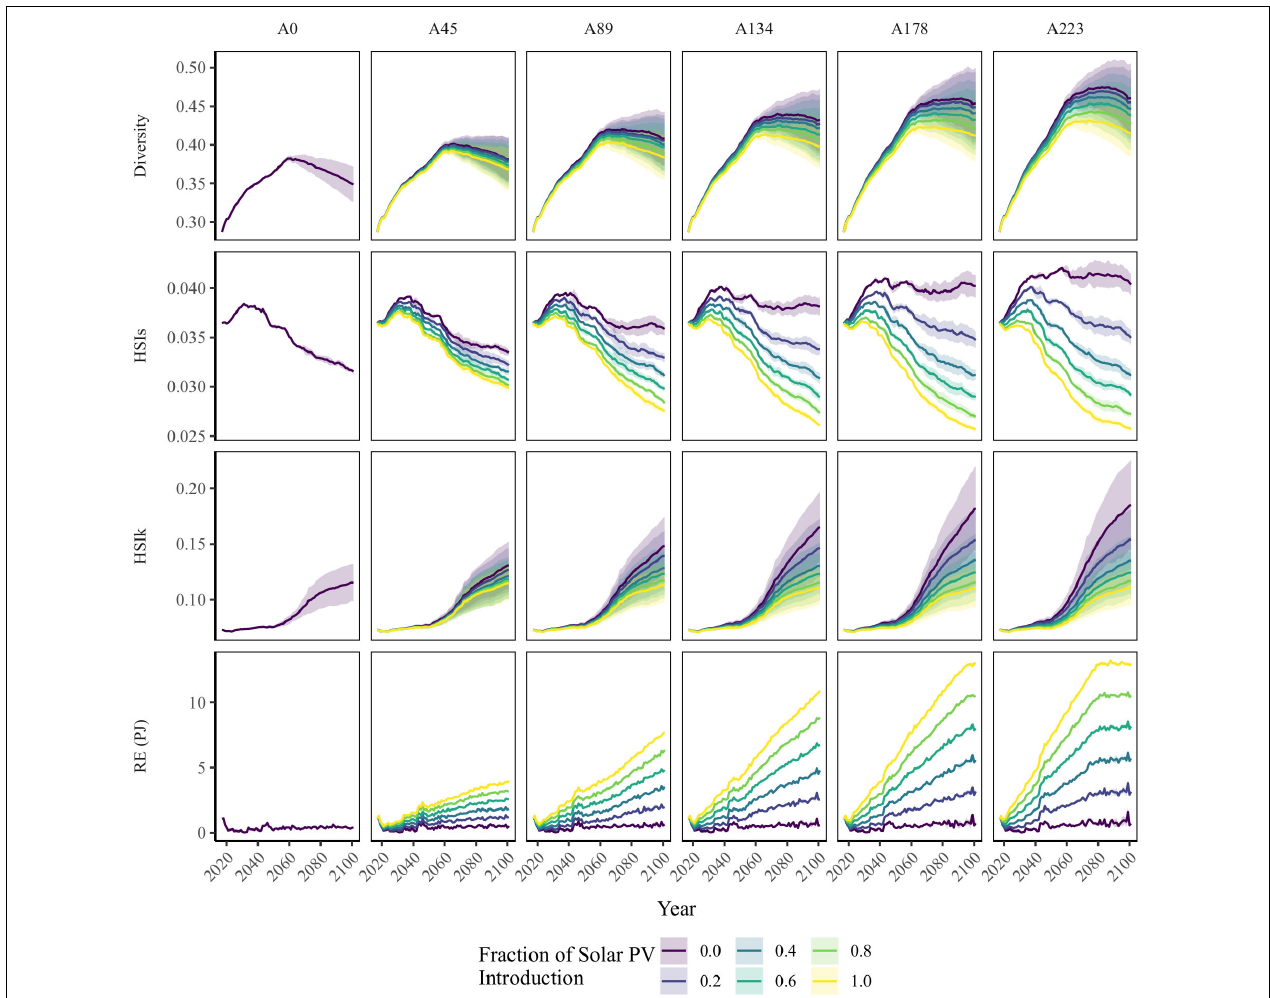
FIGURE 3 | IPCC RCP 2.6 and 8.5 scenarios for the three ecological indicators and renewable energy (RE) production potential from 2016 to 2100 for the 62 scenarios. Each line represents the mean between the two RCP scenarios, and the difference between the scenarios is represented by shading. A0–A223 represent the pastureland abandonment expansion speed, and the colors indicate the solar PV plant fraction ( Table 1 ). Diversity = Shannon–Wiener diversity index, HSI s = habitat suitability index for the mountain hawk-eagle ( Spizaetus nipalensis orientalis ), HSI k = habitat suitability index for Blakiston’s fish owl ( Ketupa blakistoni blakistoni ), and RE = the total renewable energy supply from tree biomass utilization and solar PV